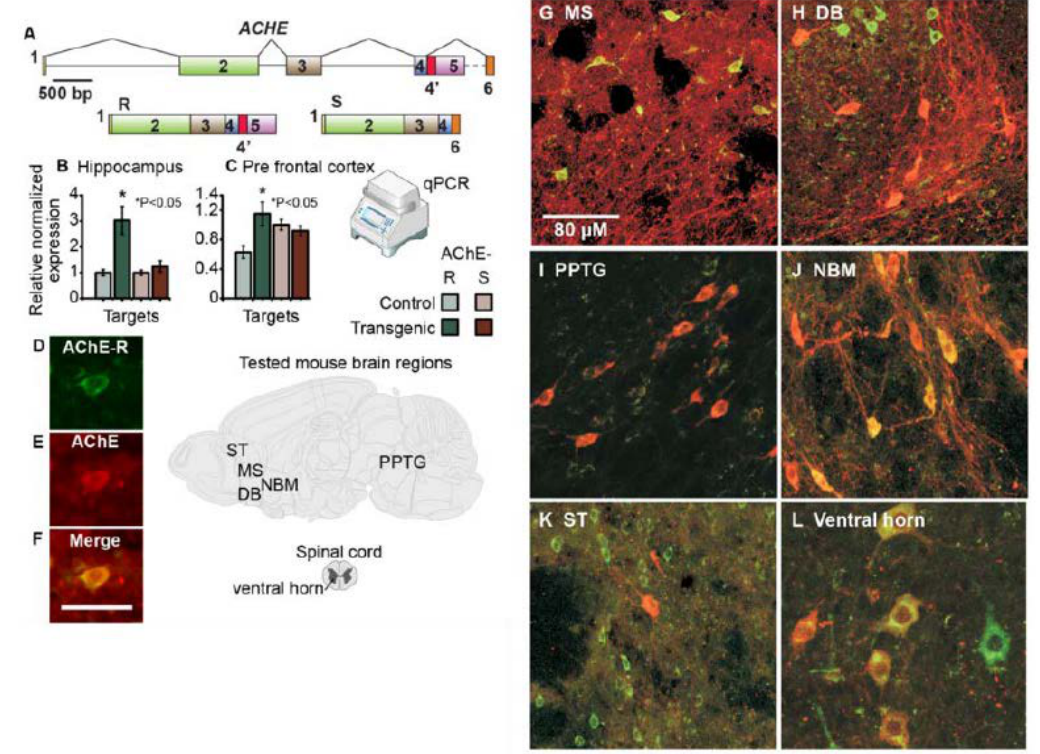
Figure 3. ( A ) Simplified structure of the human ACHE gene with its synaptic (AChE-S) and “readthrough” (AChE-R) mRNA 3 (cid:48) alternative splicing products. ( B , C ). Quantitative PCR shows selective increases of the stress-induced AChE-R variant in the cholinoceptive hippocampi of TgR mice, and more modest increases of both AChE-S and AChE-R in the cholinergic prefrontal cortex. Results were normalized to RPL19. ( D – F ). AChE-R overexpression in matrix cells positive for the common AChE domain, but not in patches. No hAChE-R labeling appeared in cholinergic nuclei with intense choline-acetyltransferase (ChAT) staining in the medial septum (MS) ( G ), diagonal band (DB) ( H ), and the prepontine tegmental nucleus (PPTG) ( I ). hAChE-R labeling co-appeared in cholinergic nuclei expressing ChAT, with moderate to weak staining, e.g., in the nucleus basalis magnocellularis (NBM) ( J ), striatum (ST) ( K ) and spinal cord (ventral horn) ( L ). Red = ChAT, Green = hAChE-R, Yellow–Orange = co-localization of ChAT and